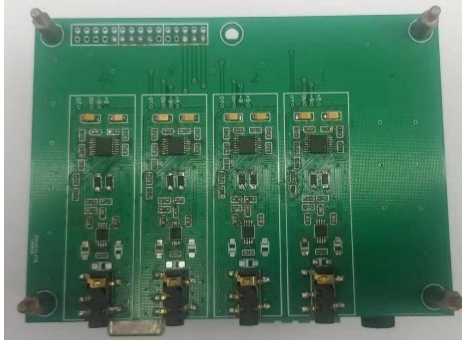
Figure 13. sEMG acquisition equipment.